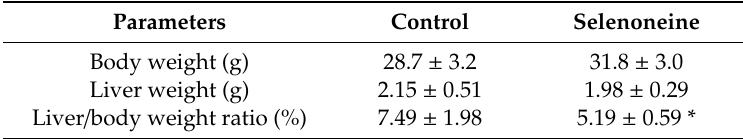
Figure 2. Changes in body weight. Mean body weight was shown at an interval of 4 days. Values are presented as mean ± SD ( n = 8). Table 1. Body and hepatic Table 1. Body and hepatic weight.